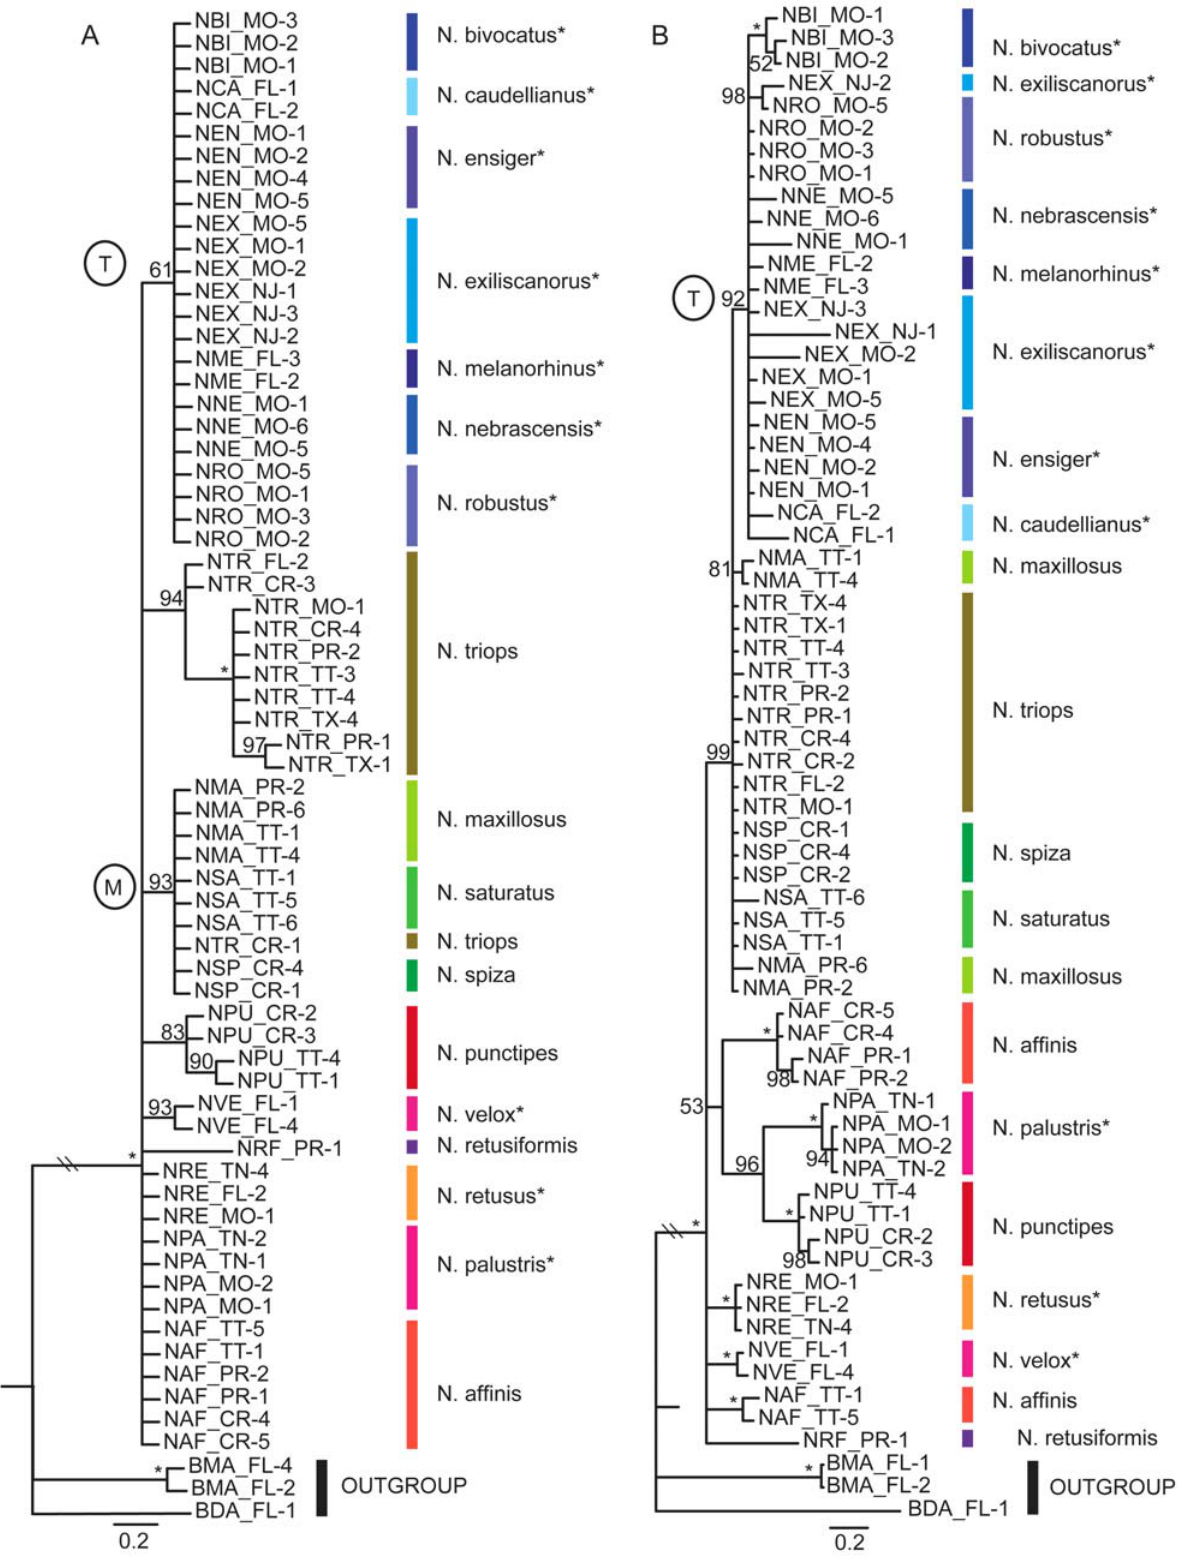
Figure 2. Phylogeny of Neoconocephalus based on nuclear genes. Bayesian phylogeny of Neoconocephalus using partial nDNA sequences H3 (a) and ITS (b). Nodal support values given as posterior probabilities in percent; asterisk indicate 100%. The temperate clade and the N. maxillosus clade are indicated by labels ‘T’ and ‘M’, respectively. Branch lengths drawn to scale. The taxa included in these phylogenies are listed in Table S1. Asterisks at the species names indicates temperate life history. Species are indicated by colored lines.